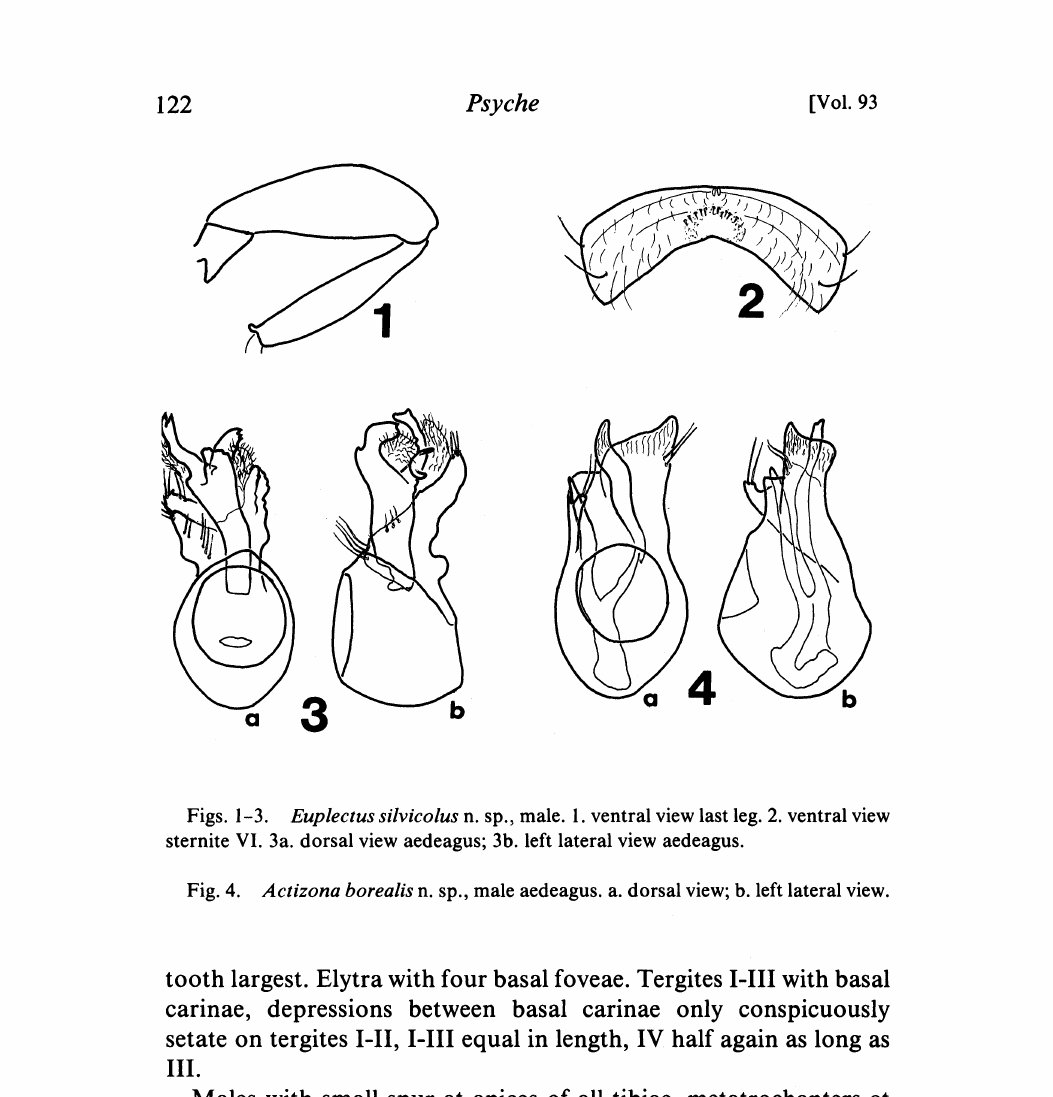
Fig. 4. Actizona borealis n. sp., male aedeagus, a. dorsal view; b. left lateral